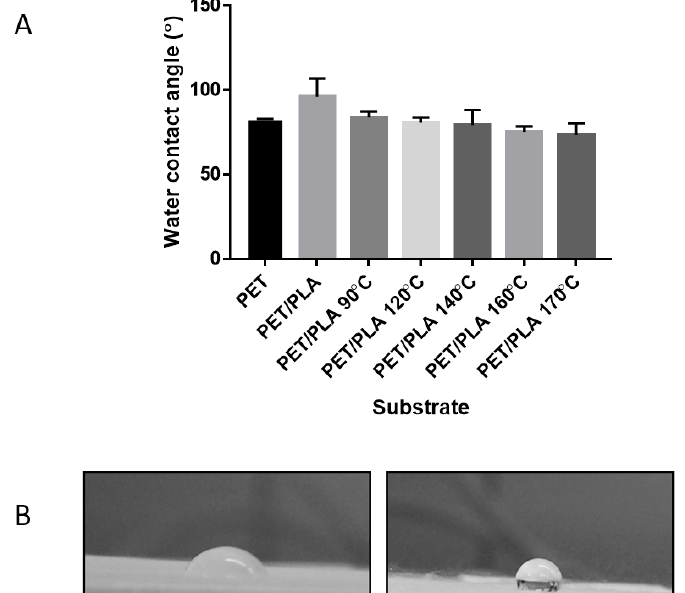
Figure 5. ( A ) Apparent water contact angle measurements of the uncoated polyethylene terephthalate (PET) film and coated with electrospun polylactide (PLA) fibers without annealing and annealed at 90 °C, 120 °C, 140°C, 160 °C, and 170 °C. The annealing time was 15 s in all samples. ( B ) Digital images of the contact angle performed on the PET films before (left) and after deposition (right) of the electrospun PLA fibers.